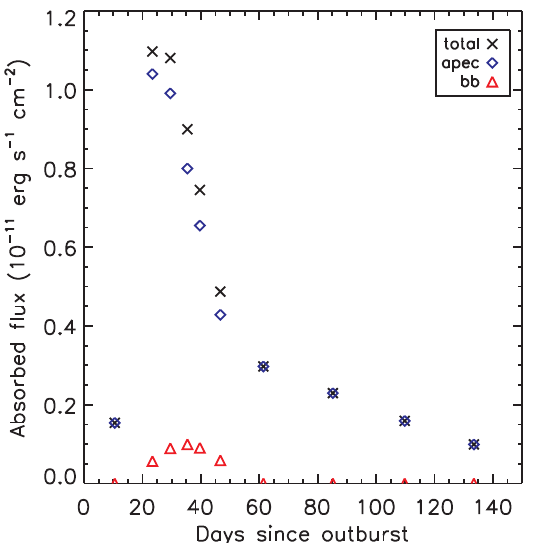
Fig. 2. The X-ray (cid:13)ux evolution of the hard (APEC) and soft (blackbody) components of V407 Cyg, as inferred from Swift XRT data. emission measure, kT , and N H all declined sharply, and thereafter they declined at a much reduced